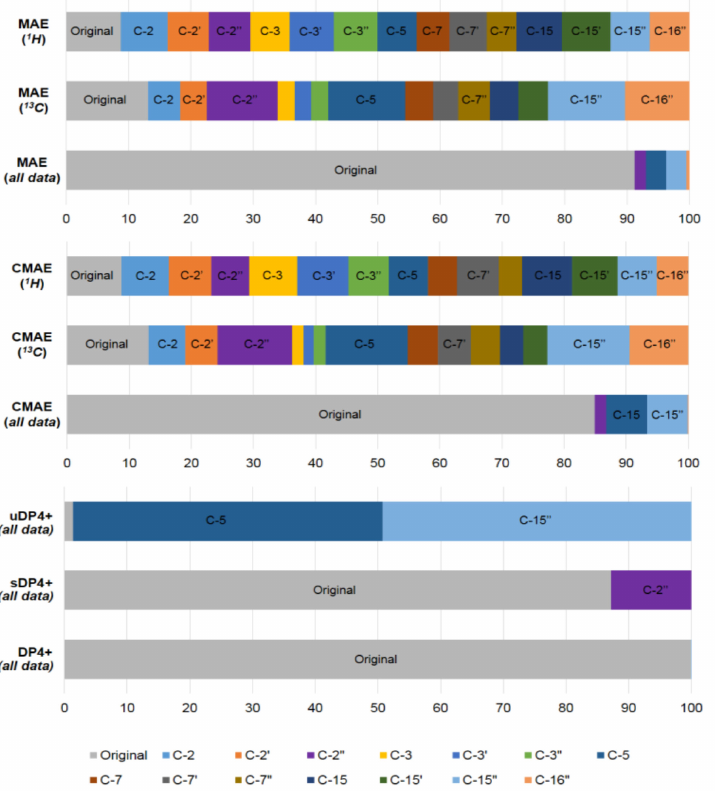
Figure 3. Graphs of the DP4+ probability distribution for each diastereomer of strychnohexamine ( 1 ) together with the probabilities derived from the performed correlation analysis and the values of the resulting MAE and CMAE. Reproduced from Semenov et al. [59] with the permission of John Wiley and